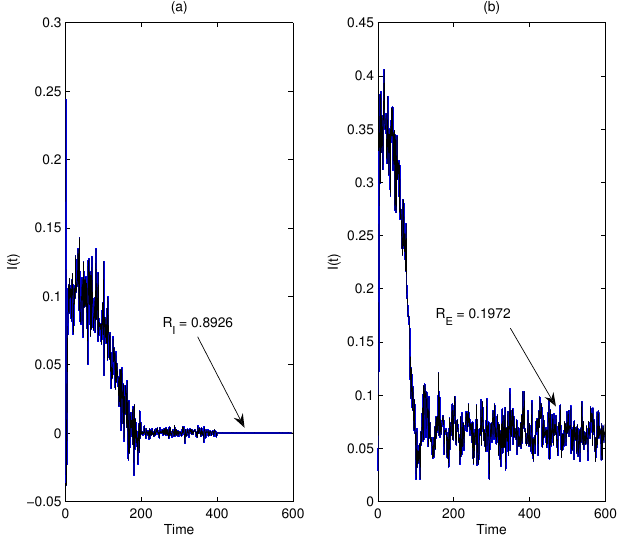
√ Figure 5. If σ i 1 ( n ) = 0.09 + 0.04sin n , σ i 2 ( n ) = 0.2 + 0.09sin n ( i = 1,2,3,4 ) , c 1 ( u ) = 0.04, c 2 ( u ) = 0.3, c 3 ( u ) = 0.06, c 4 ( u ) = 0.03 and initial value ( 0.35,0.15,0.04,5 ) , dynamical responses of the infected individual I ( t ) are shown in ( a , b ), respectively. It can be obtained that R I = 0.8926 < 1, which follows that infectious disease becomes extinct exponentially. In other words, if c 1 ( u ) = 0.4, c 2 ( u ) = 0.03, c 3 ( u ) = 0.02, c 4 ( u ) = 0.05, then it can be obtained that R E = 0.1972 > 0, which follows that infectious disease persists in